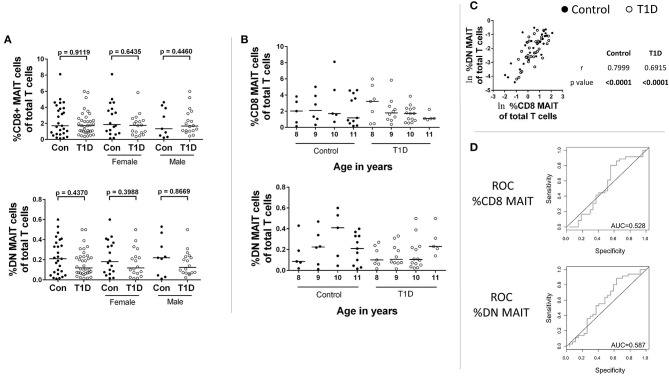
CD8 and DN MAIT cell frequencies among control and T1D subjects. (A) Frequency of CD8 MAIT cells and DN MAIT cells of total T cells among control and T1D subjects, as well as stratified by sex. (B) Subjects were divided according to their age in years to allow for visual examination of differences. (C) Correlation between CD8 MAIT cell frequency and DN MAIT cell frequency among T1D and control subjects. (D) Receiver operating characteristic (ROC) curves for CD8 and DN MAIT cell frequencies as predictors of T1D compared to control. For graphs in (A,B), bars are median values. For (C), ln denotes that values were transformed using natural logarithm. AUC, area under the curve.